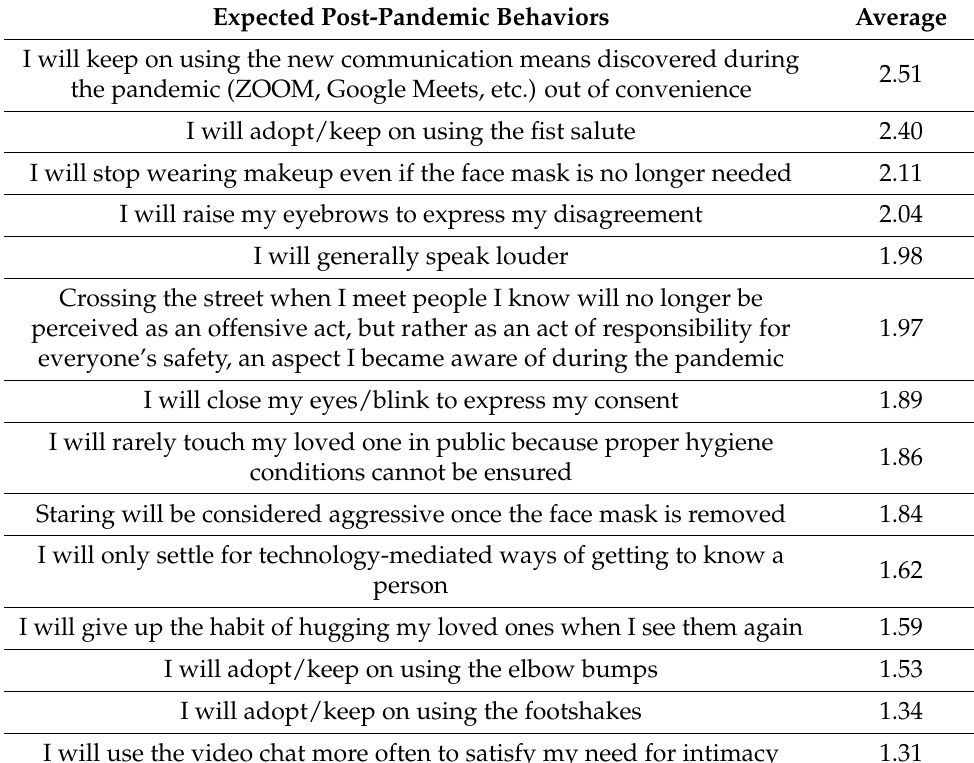
Table 6. Expected post-pandemic behaviors on a scale from 1 to 5.